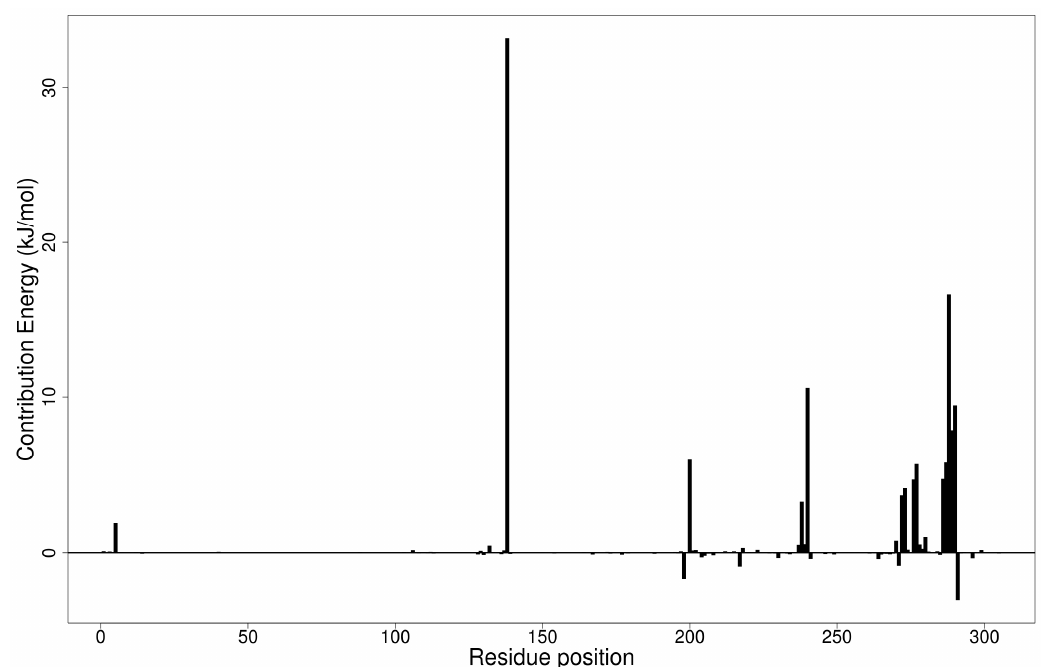
Figure 4. Molecular mechanics/Poisson-Boltzmann surface area (MM/PBSA) plot of binding free energy contribution per residue of the M pro -ZINC000095486008 complex.